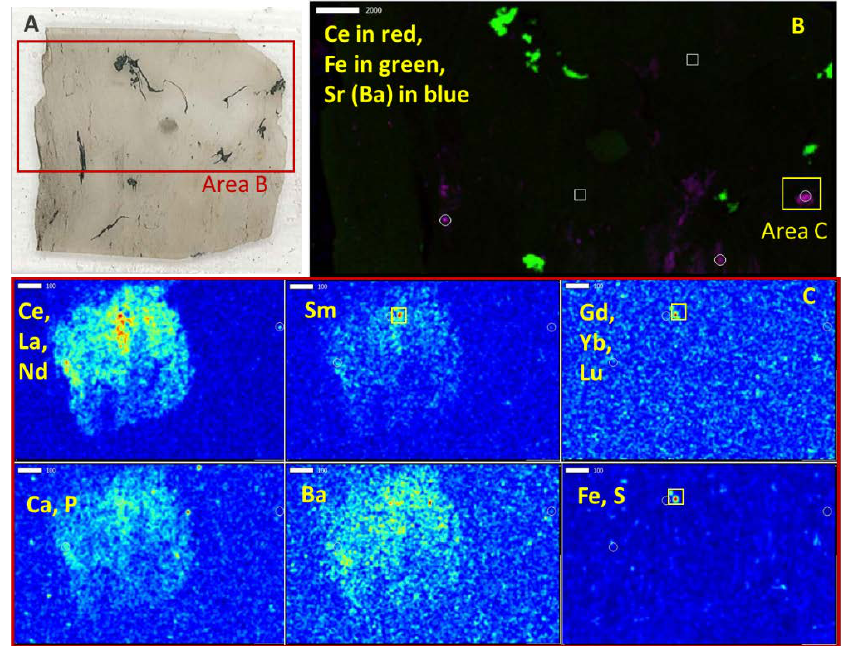
Figure 7. ( A ) Photo of thin section of UC-01, Lower Freeport, highlighting Area B for µXRF mapping at BL10-2; ( B ) Tri-colored µXRF maps (Ce in red, Fe in green and Sr in blue) at BL10-2 with 50µm step size, 50 ms dwell time at excitation energy of 18,100 eV. The scale bar is 2000 µm. Ce is co-localizing with Sr and Ba, demonstrated by the purple color on the tri-colored map. Highlighted box is mapping area C at BL2-3; ( C ) µXRF elemental maps at BL2-3 with 5 µm step size, 50 ms dwell time at excitation energy of 9500 eV. The scale bar is 100 µm. The color scale on each map from blue to yellow to red represents XRF signal intensity from low to high, as displayed in all other µXRF maps.